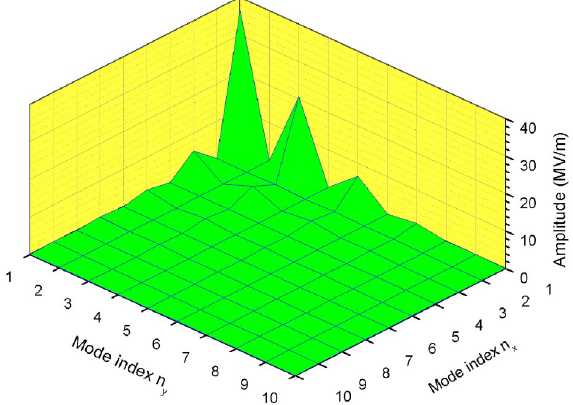
FIG. 10. (Color) Mode amplitude vs mode indices n one drive bunch. It is seen that the modes with ( n 3, 5) corresponding to the wavelengths 21.75, 21.56, and 21 : 19 (cid:4) m are dominant (36.6, 20.6, and 6 : 6 MV = m ), and next the modes with ( n the wavelengths 5.02, 5.01, and 5 : 00 (cid:4) m are relatively weak (5.3, 3.1, and 1 : 0 MV = m ). The modes with even n excited and those modes with n ignored in